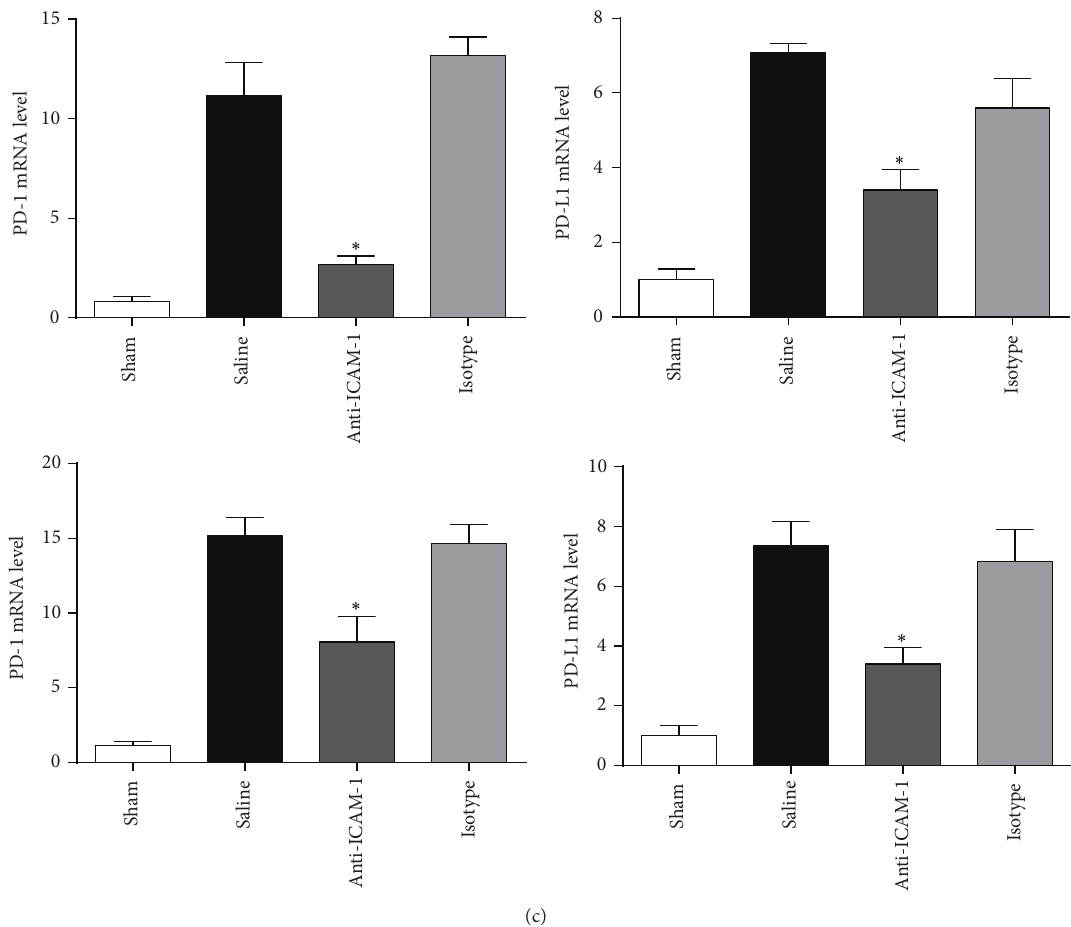
Figure 5: Effect of ICAM-1 blockade on the immune status in thymus and spleen. (a) Representative sections analyzed by the in situ TUNEL assays. Apoptotic cells were significantly reduced by anti-ICAM-1 treatment in thymus and spleen. (b) RT-PCR assays of costimulatory molecules in thymus and spleen, including CD28, CD80, CD86, PD-1, and PD-L1. 𝑛 = 6 per each group. ∗ 𝑃 < 0.05 when anti-ICAM-1 antibody treated mice were compared with mice treated with isotype antibody or saline. Bars represent the mean ±